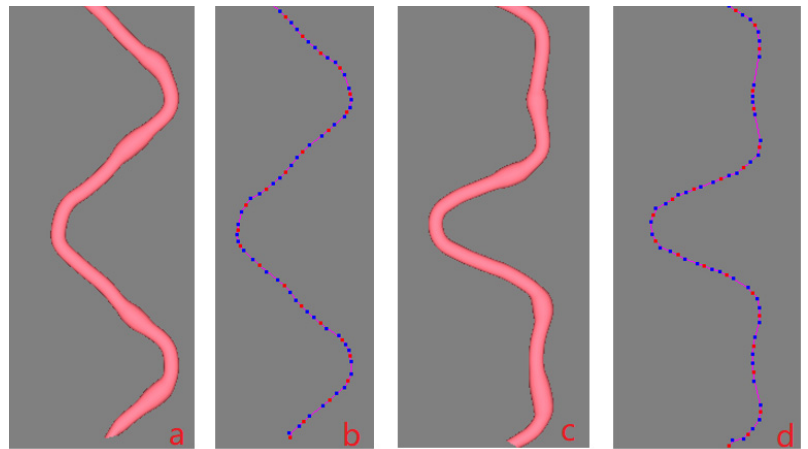
Figure 15. Enlarged generated central curves after mapping (local image). ( a ) The enlarged mapping effect of Figure 14c. ( b ) The control points of the mapped curve in Figure 15a. ( c ) The enlarged mapping effect onto the targe curve Figure 14b. ( d ) The control points of the mapped curve in Figure 15c.